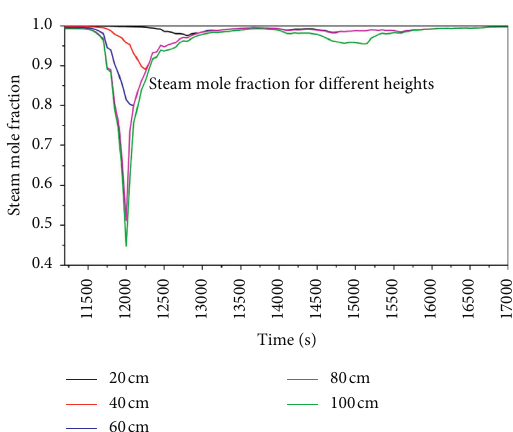
Figure 19: Variation of steam mole fraction at different